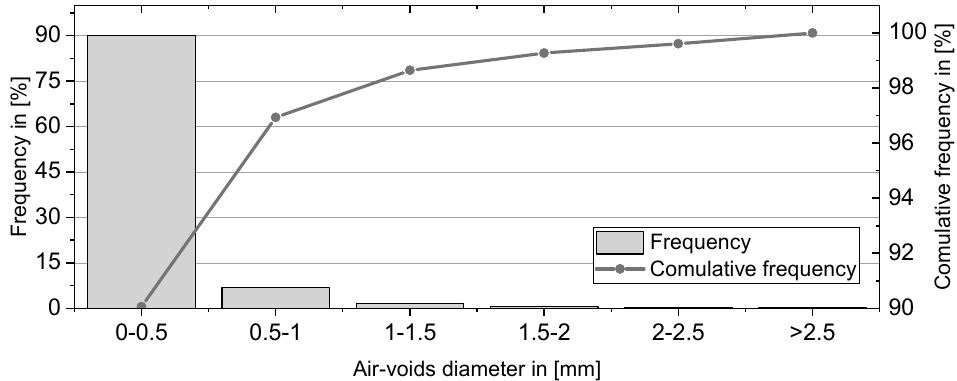
Figure 12. Air voids size distribution in the foam concrete M-2.